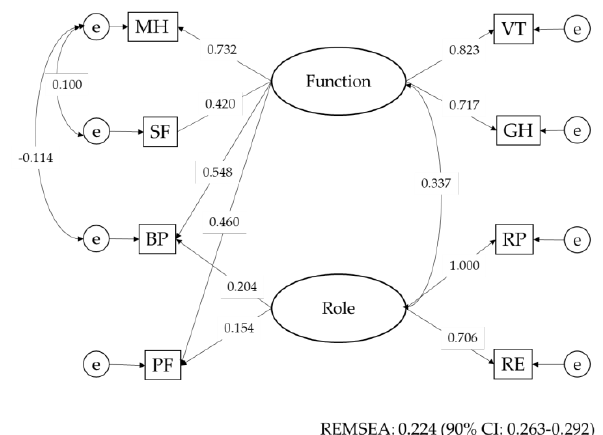
Figure 1. Structure of quality of life of the older subjects at the age of 85. The subscales of the SF 36 consisted of two latent variables, named Function and Role. All paths were statistically significant. BP and PF correlated with both latent variables. Subscales: Physical functioning (PF), Role physical (RP), Body pain (BP), General health (GH), Vitality (VT), Social functioning (SF), Role emotional (RE), Mental health (MH), e: Error variable. SF 36: 36-Item Short-Form Health Survey. REMSEA: root-mean-square error of approximation.